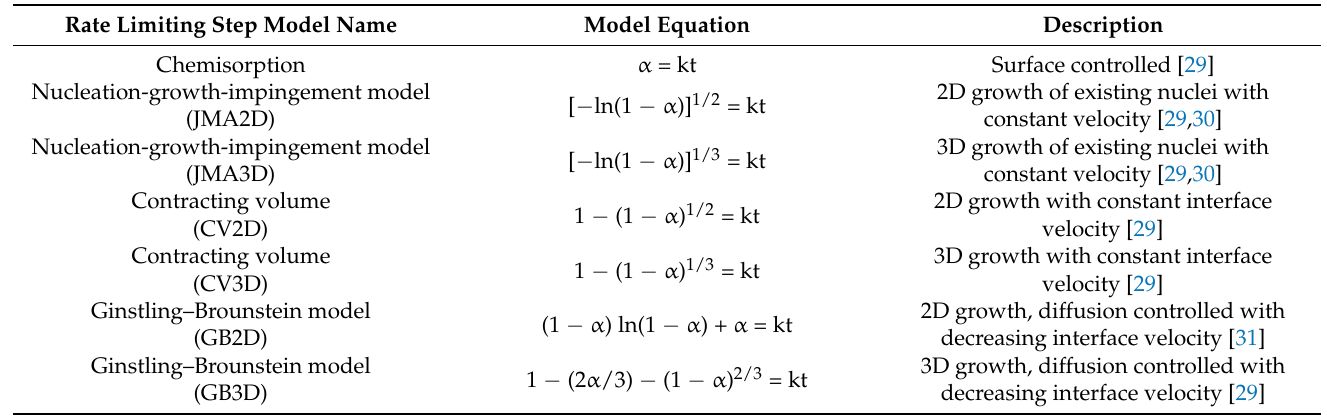
Table 6. Model equations for rate limiting step